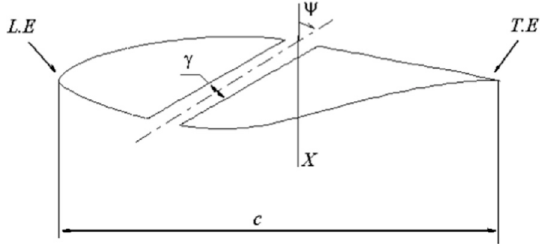
Figure 17. Airfoil with slot—Passive flow control [170].